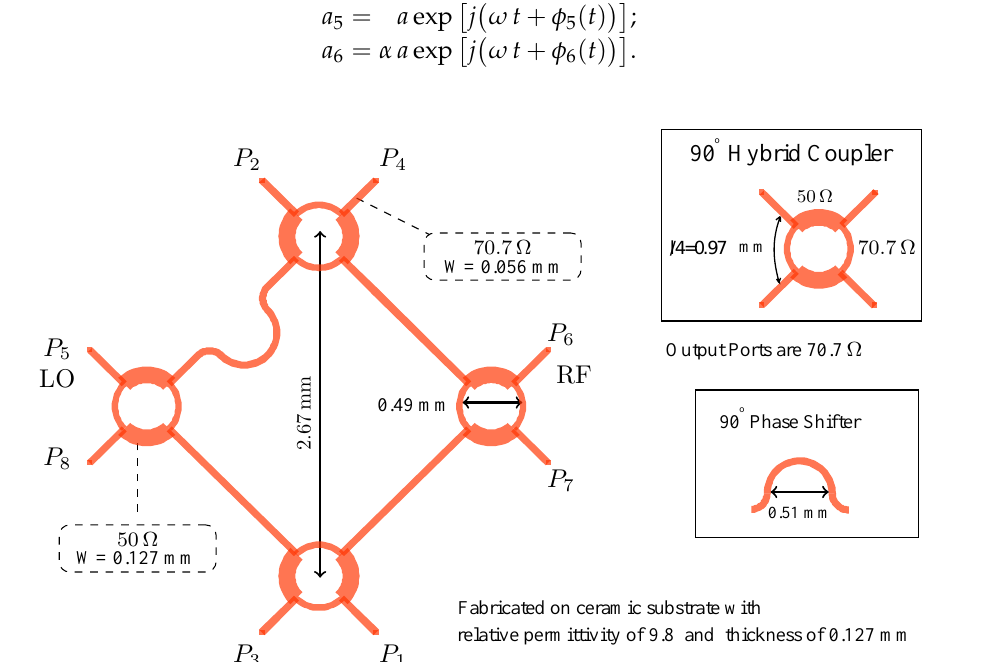
Figure 2. Layout of the six-port interferometer. LO, local oscillator. Figure 3. Layout of the six-port interferometer.